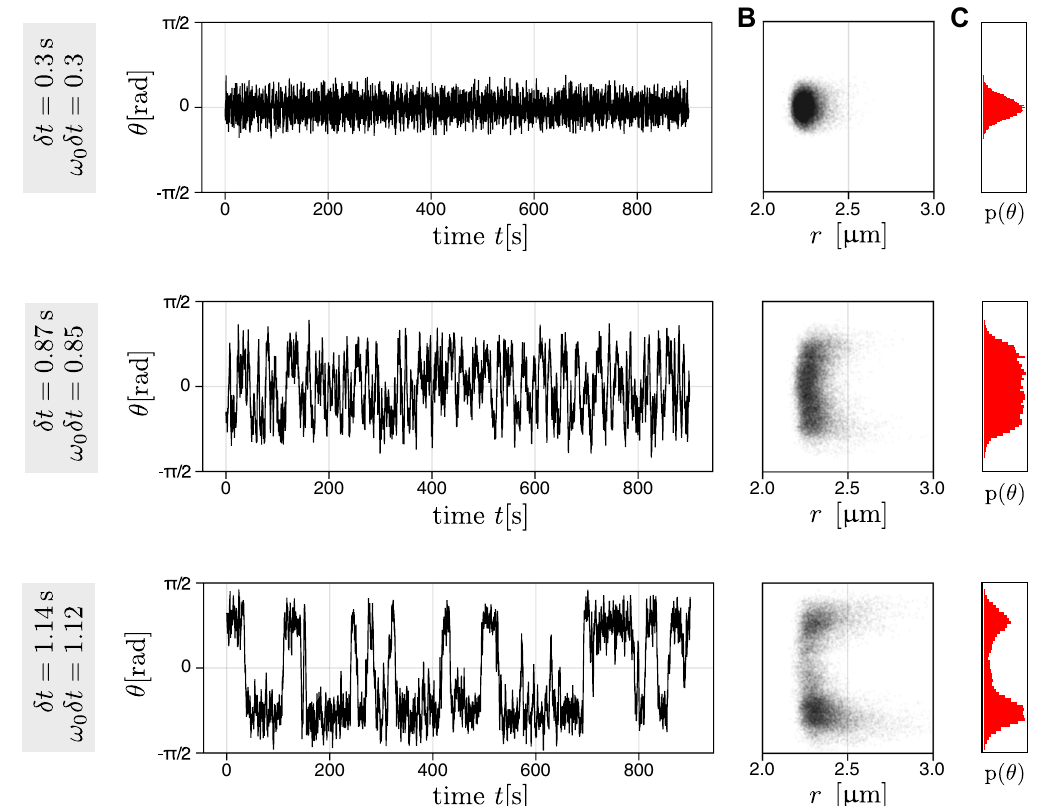
Fig. 2 | Propulsion angle at the different programmed delay. A Trajectories of the propulsion angle θ ( t ) of an active particle at three different delays (top: δ t = 0.3s, middle: δ t =0.87s, and bottom: δ t =1.14s) for its attraction towards a target particle.Thevelocityoftheactiveparticleis v 0 =2.16 μ ms − 1 . B Propulsionangle θ ( t )